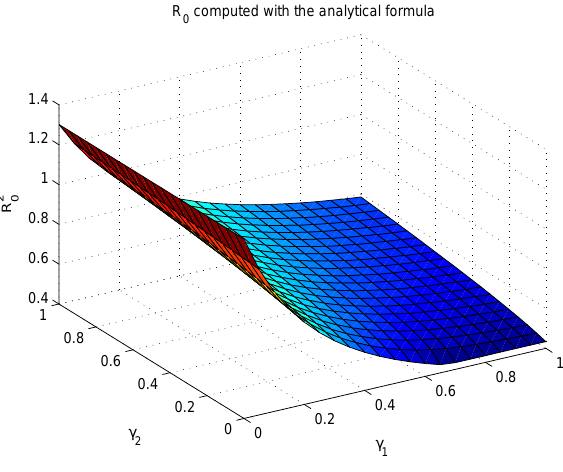
Fig. 8. Evolution of R 2 0 with respect to γ 1 and γ 2